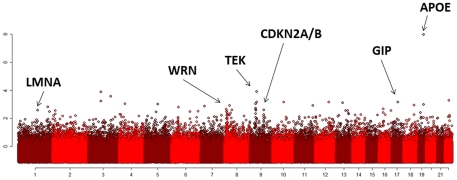
The Manhattan plot displays the maximum log10(Bayes Factor) (y-axis) for each of the analyzed SNPs in the discovery set. The SNPs are ordered by chromosome (alternate color bands) and, within chromosome, by physical position (x-axis). We tested the association of each SNP with exceptional longevity using general, allelic, dominant and recessive models and the y-axis reports the maximum log10(Bayes factor) observed for each SNP. The SNP rs2075650 in APOE/TOMM40 reached irrefutable genome wide significance (log10(MBF) = 7.9 and p-value<e-10). Figure S3 shows the Manhattan plot and QQ plot for the additive model using logistic regression.